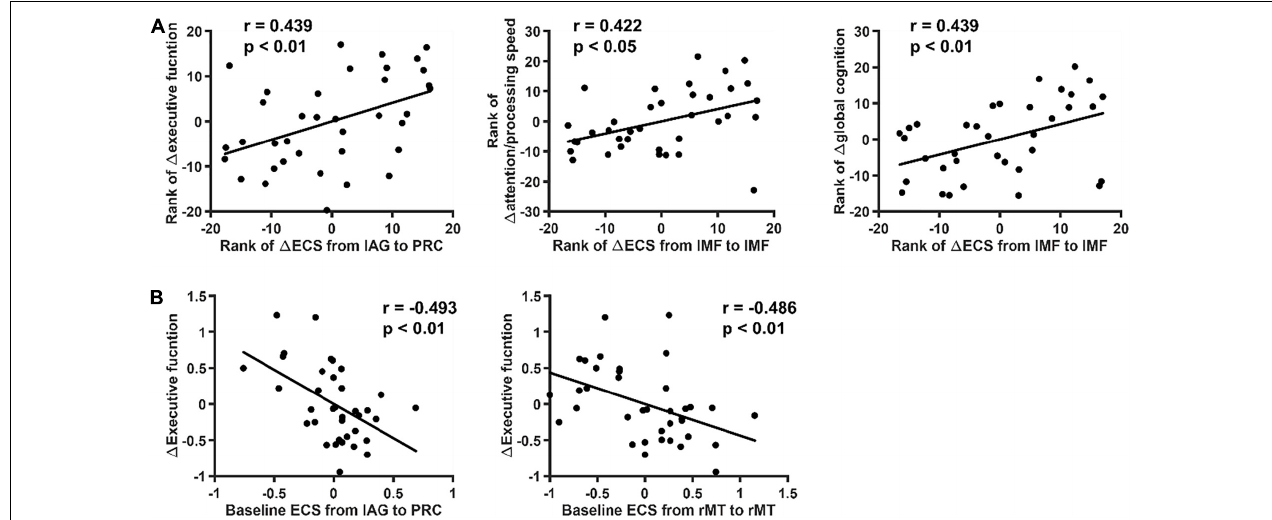
FIGURE 5 | Relation between effective connectivity strength (ECS) and cognition. The relation between ECS and significantly declined cognition was explored. The data shown in the figure were controlled for sex, baseline age and education years. These p -values survived correction for FDR < 0.05. (A) Spearman correlation coefficients between 4-year changes of ECS in each network and significantly declined cognitive scores. Significant correlations were found between changes of ECS of self-inhibition of the left middle frontal gyrus and cognition alterations in attention/processing speed and global cognition. (B) Linear regression correlation coefficients between baseline ECS and cognitive decline. The ECS from the left angular gyrus to the precuneus was found to be predictive of executive function